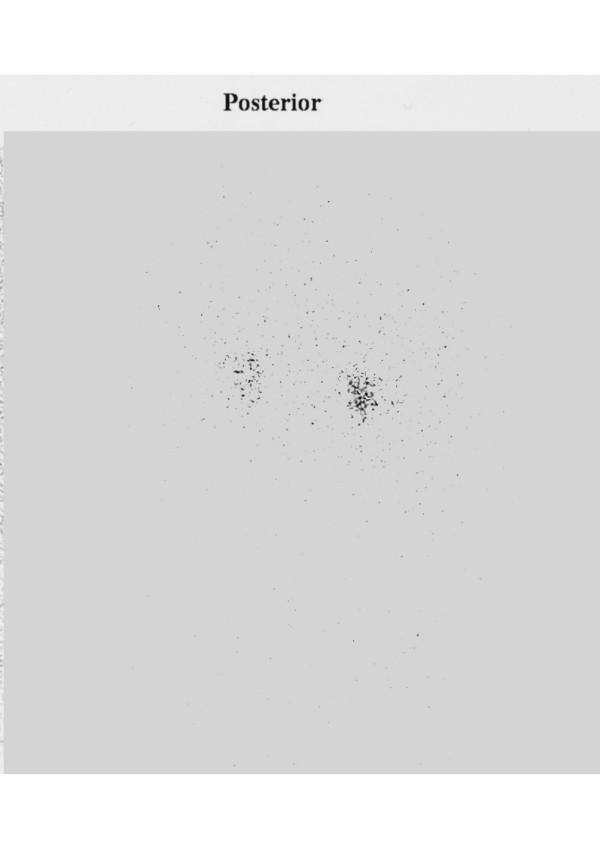
Adrenal scintigraphy reveals the uptake of I131-adosterol by the left adrenal gland.